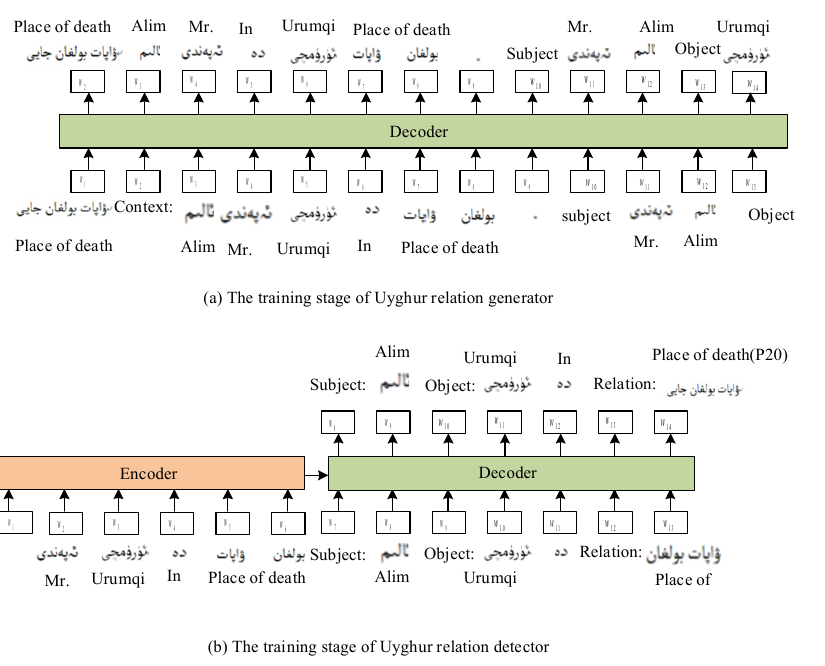
Figure 2. The Uyghur language training process for Relation Generator.